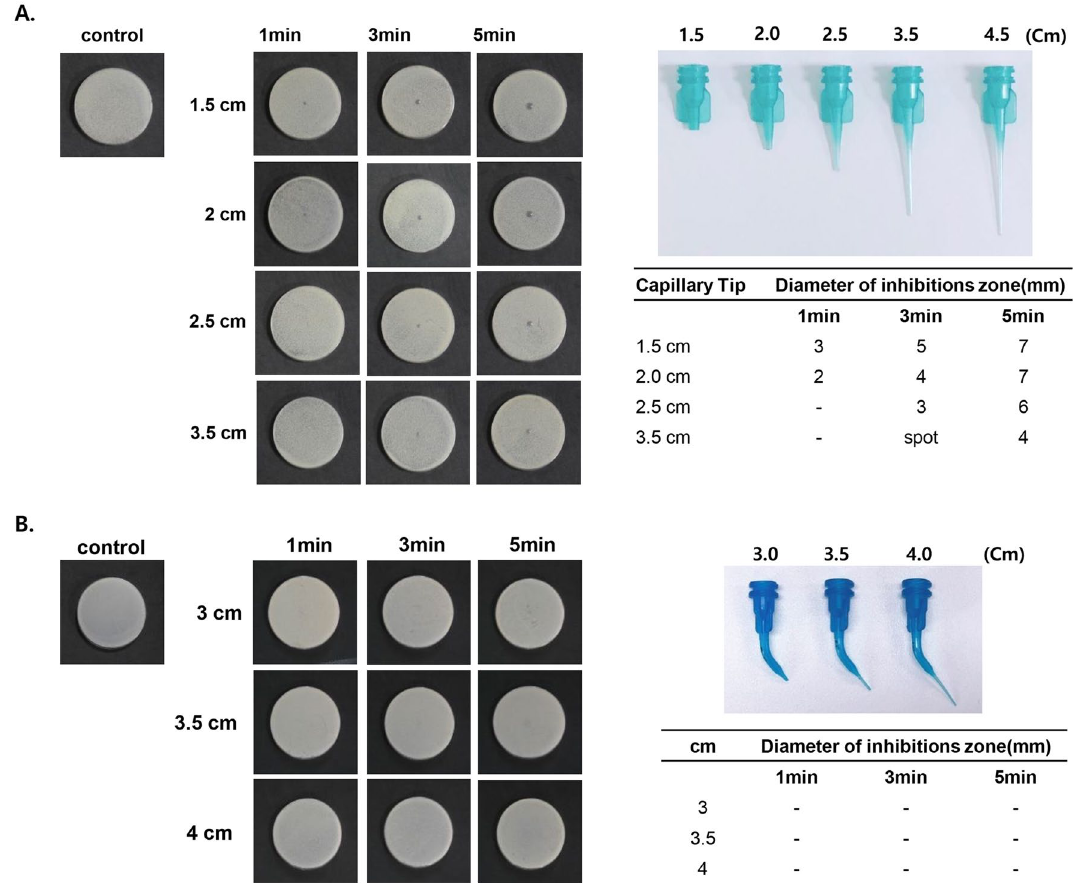
Figure 7. The effect of the dental tip length on the bactericidal effect of NCP mounted with dental tips. ( A ) The capillary tips (originally 4.5 cm in length) were cut into 1.5, 2, 2.5 and 3.5 cm, and mounted on NCP device. S. mutans inoculated on solid medium was treated with the NCP for 1, 3, 5 min. At 24 h after the treatment, the photographs showing a clear zone were taken, and the size of a clear zone was measured. ( B ) The microcapillary tips (originally 4 cm in length) were cut into 3 and 3.5 cm, and mounted on NCP device. The S.mutans on solid medium was subjected to NCP treatment for 1, 3 and 5 min. At 24 h after the treatment, the photographs showing a clear zone were taken, and the size of a clear zone was